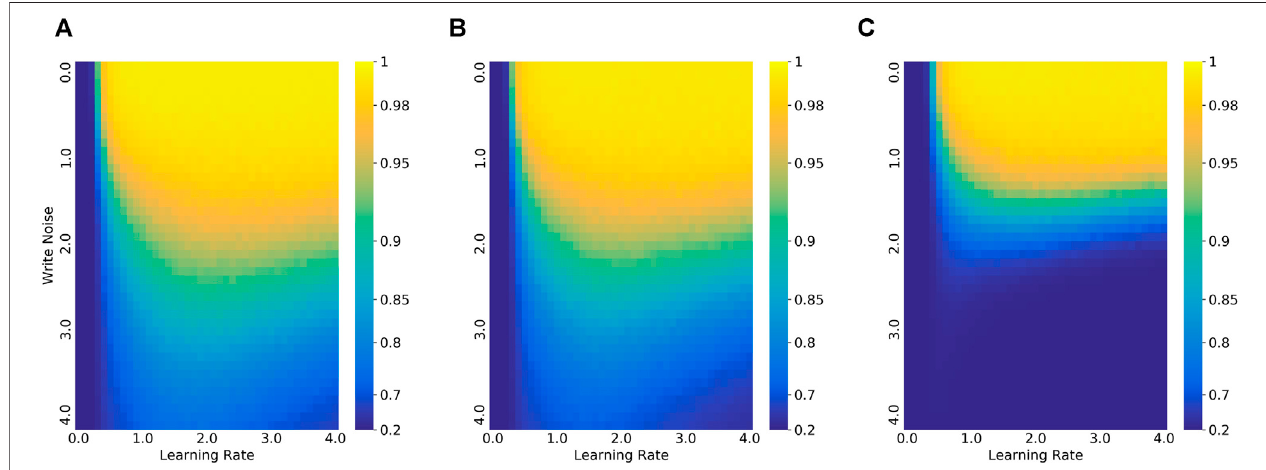
FIGURE 6 | The impact of write noise and learning rate on 5way-1shot Omniglot task. (A) ROA. (B) ROA without constraint (ROA-WC). (C) 5-step update ROA.